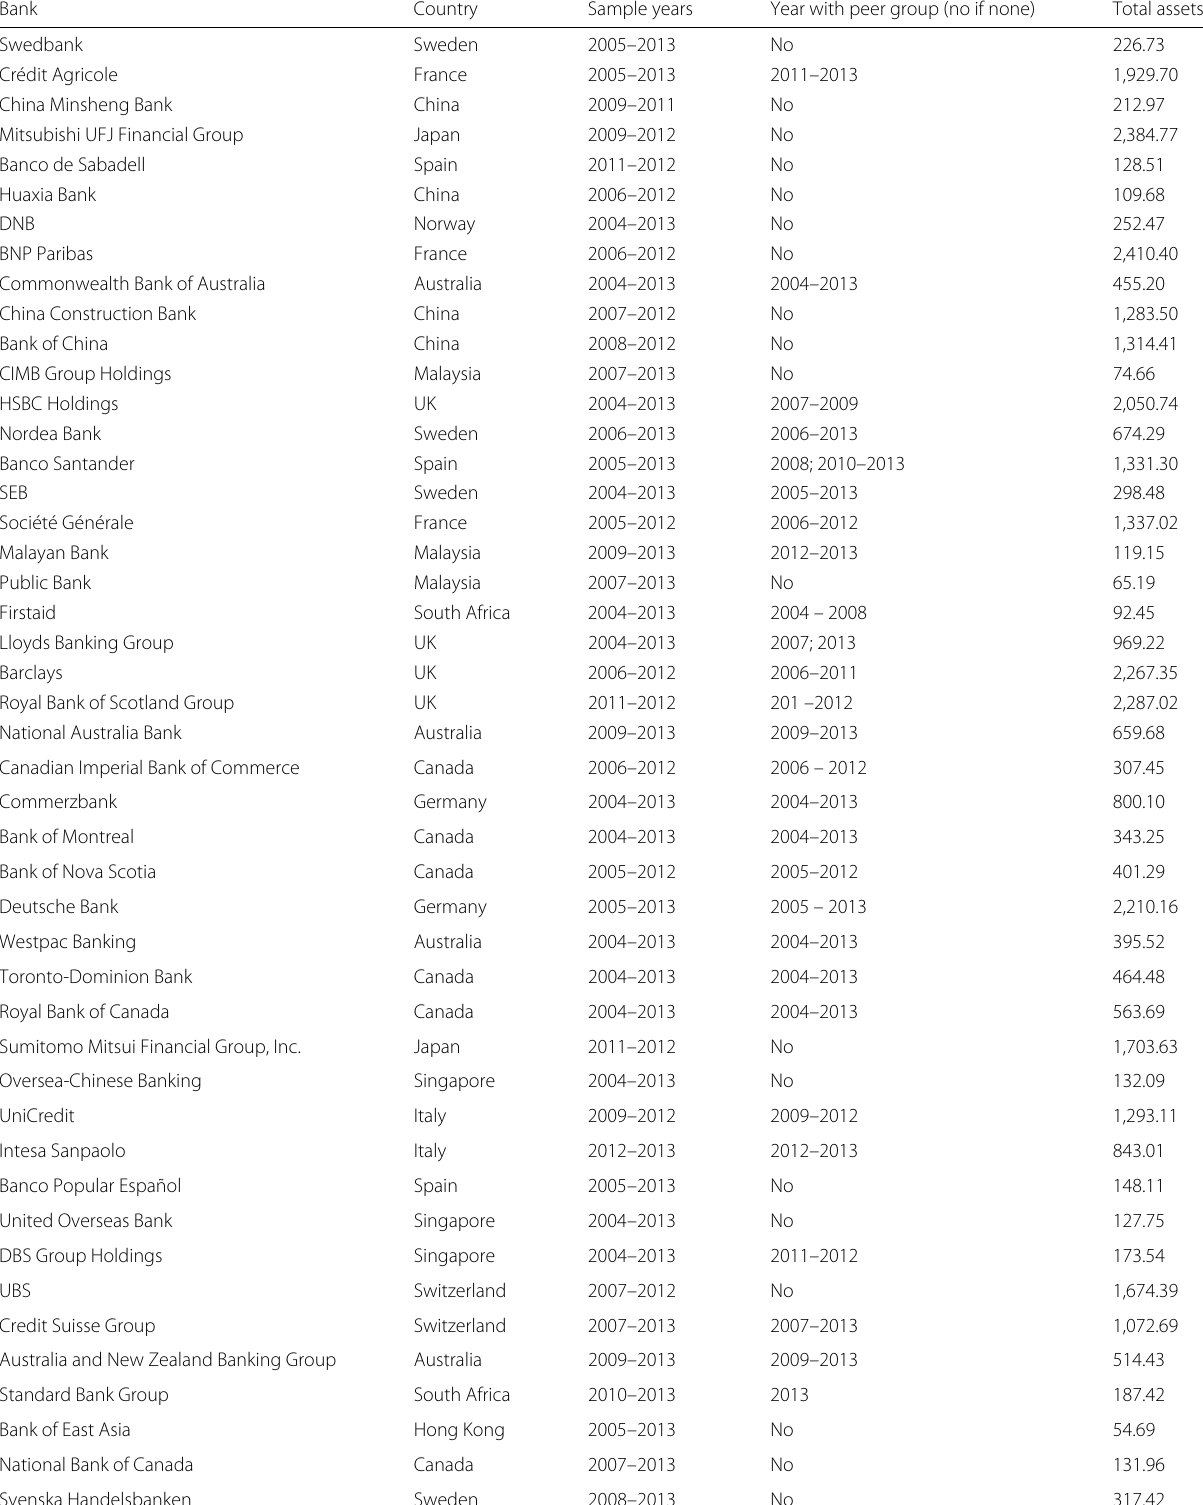
Table 12 List of international banks in the full